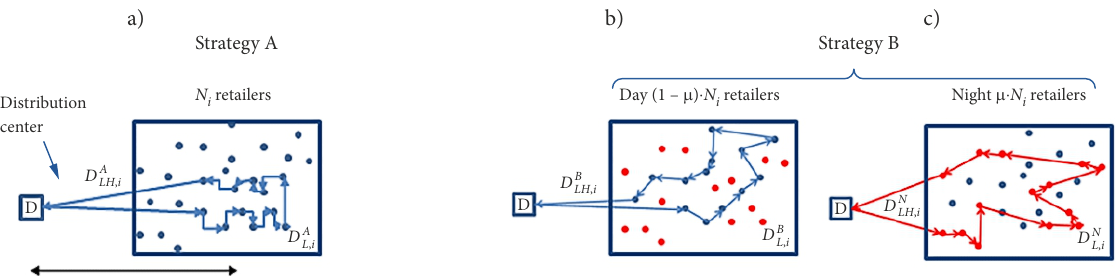
Figure 1. Comparison of distribution phases in Strategy A (a) and Strategy B (b and